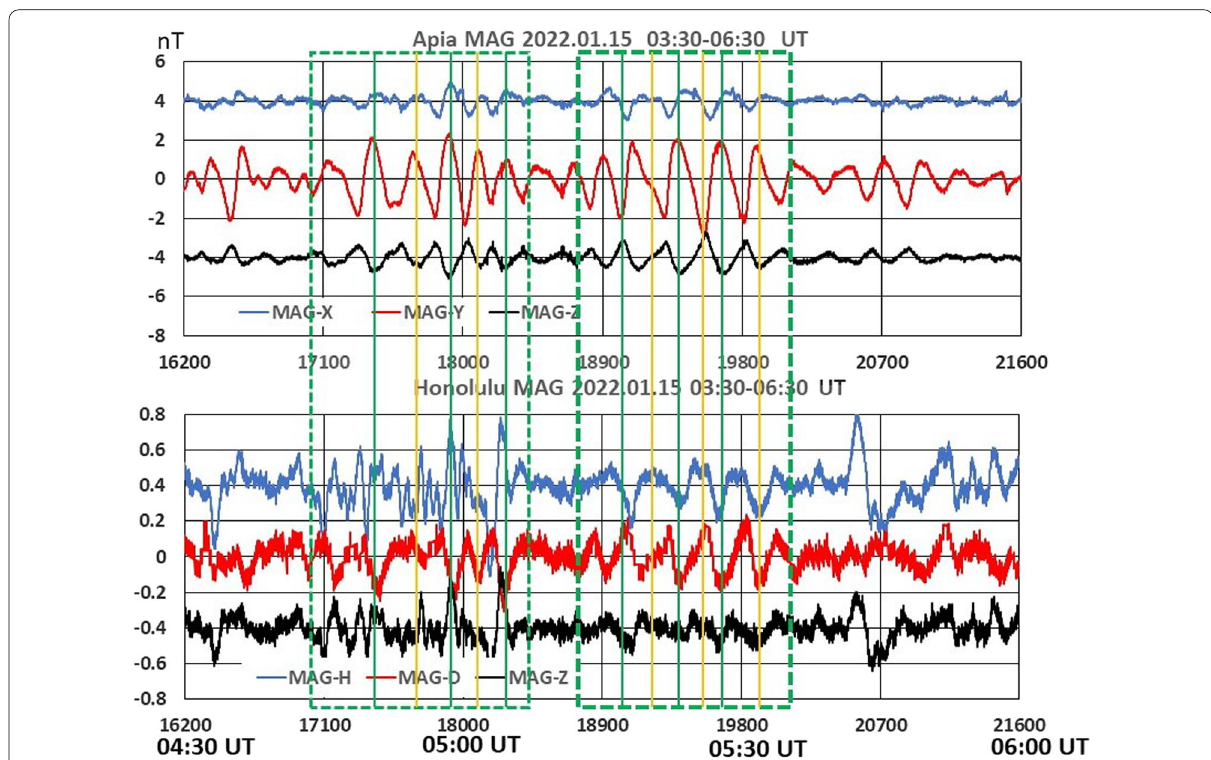
Fig. 10 Phase relation of magnetic field oscillations between Apia and Honolulu